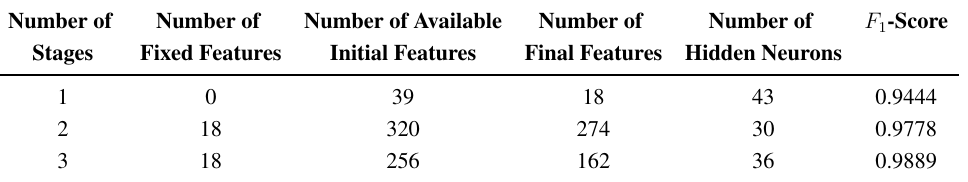
Table 5. Classifier performance by using multi-stage selection.